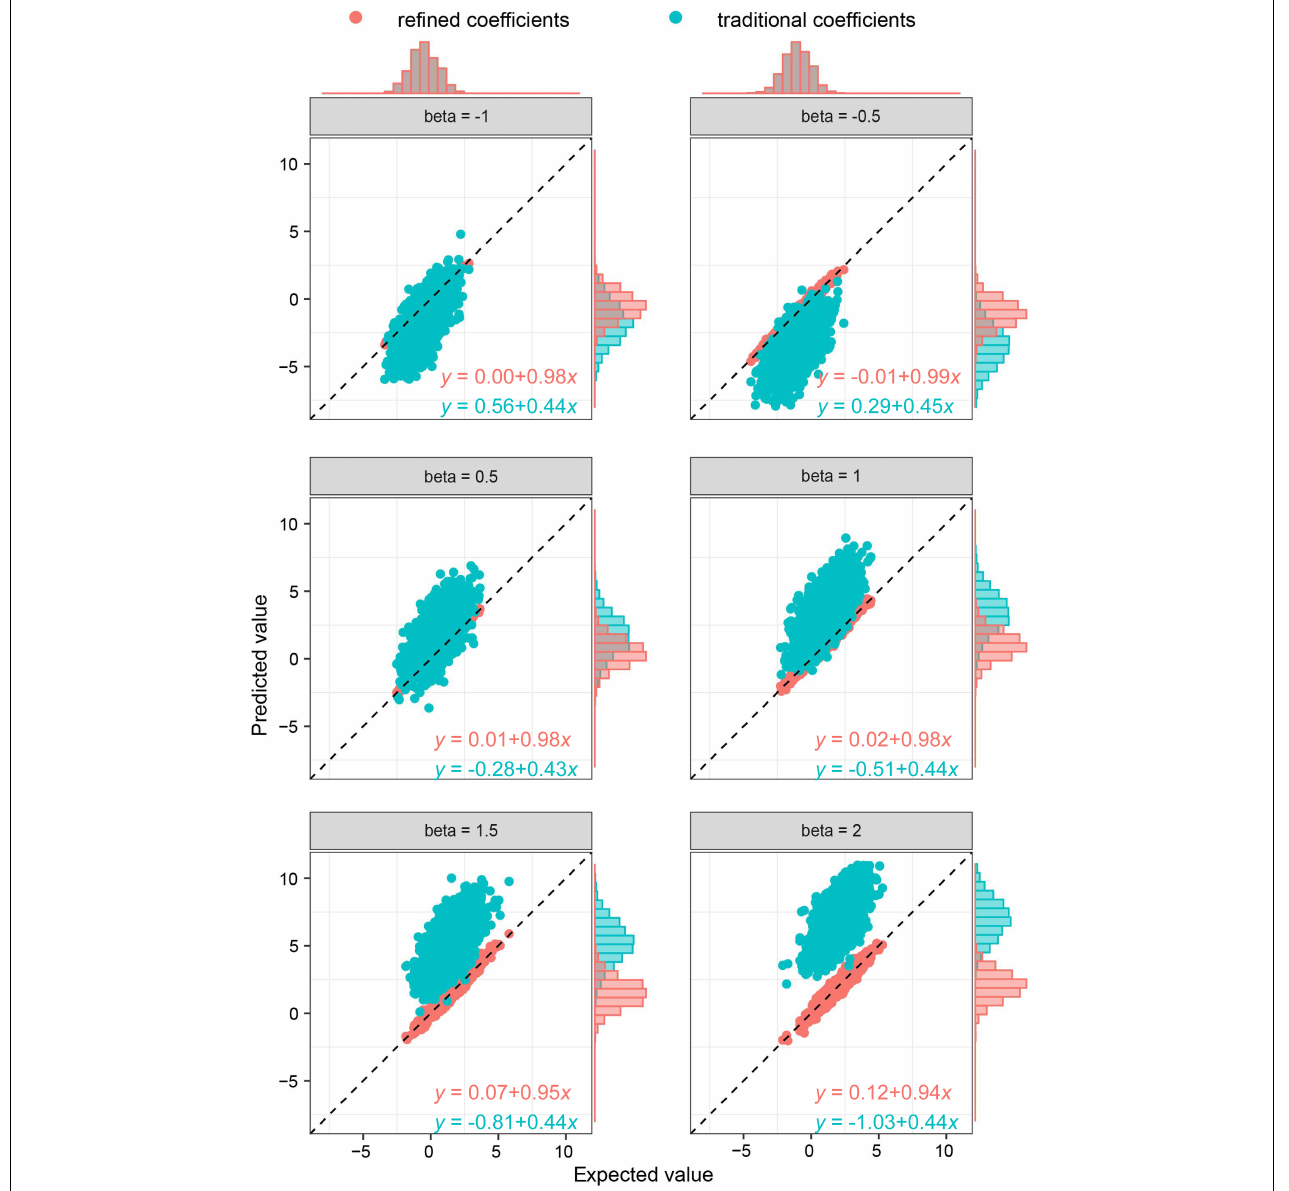
FIGURE 3 | Comparison of refined and traditional coefficients under different effect sizes. Expected values are the regression coefficients obtained from the multivariable regression model with all the variables used to generate dependent variable Y plotted against predicted values obtained from the refined method (refined coefficients) and traditional single-locus analyses (traditional coefficients). Refined and traditional coefficients were compared with the bias from expected coefficients under different effect sizes through a regression model. Red equation represents the relationship between expected coefficients and refined coefficients, and green equation represents traditional